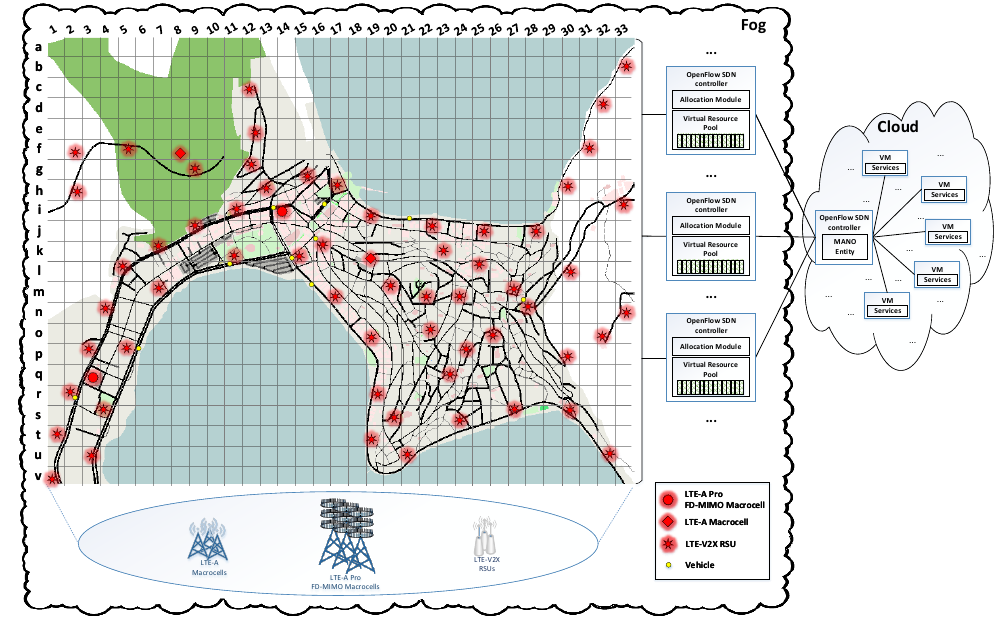
Figure 4. The simulated